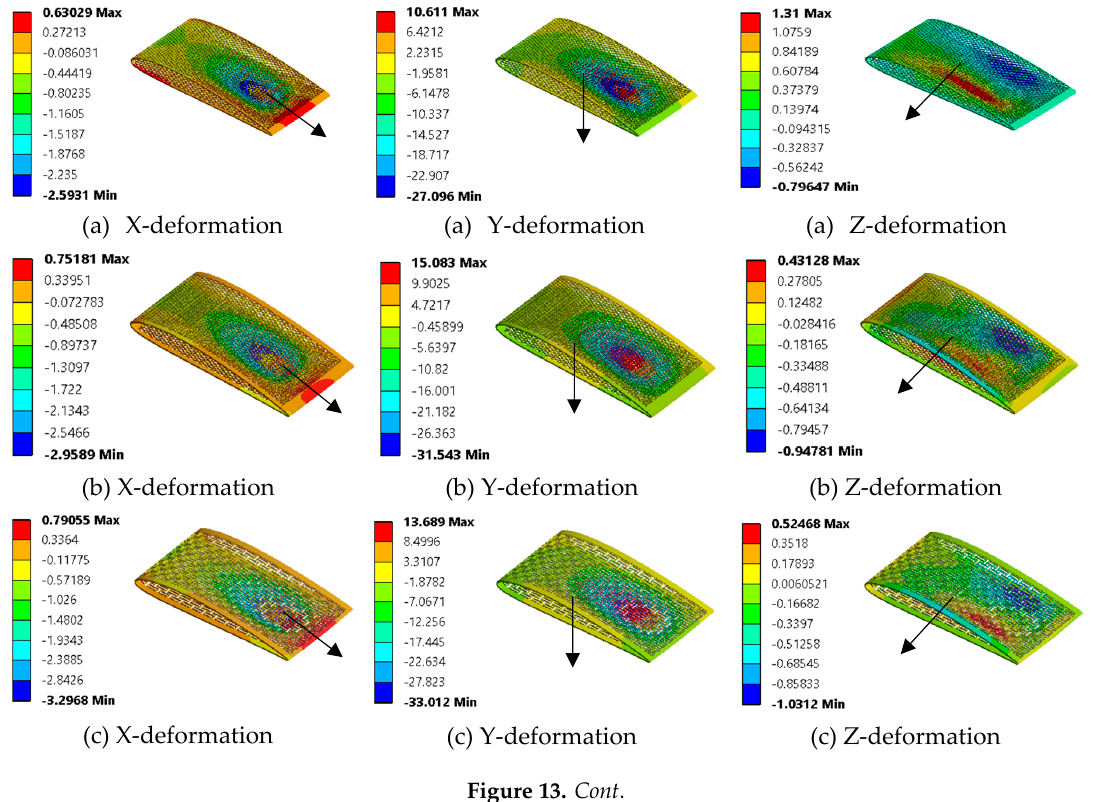
Table 3. Flexible skin models’ mechanical properties for the step morphing